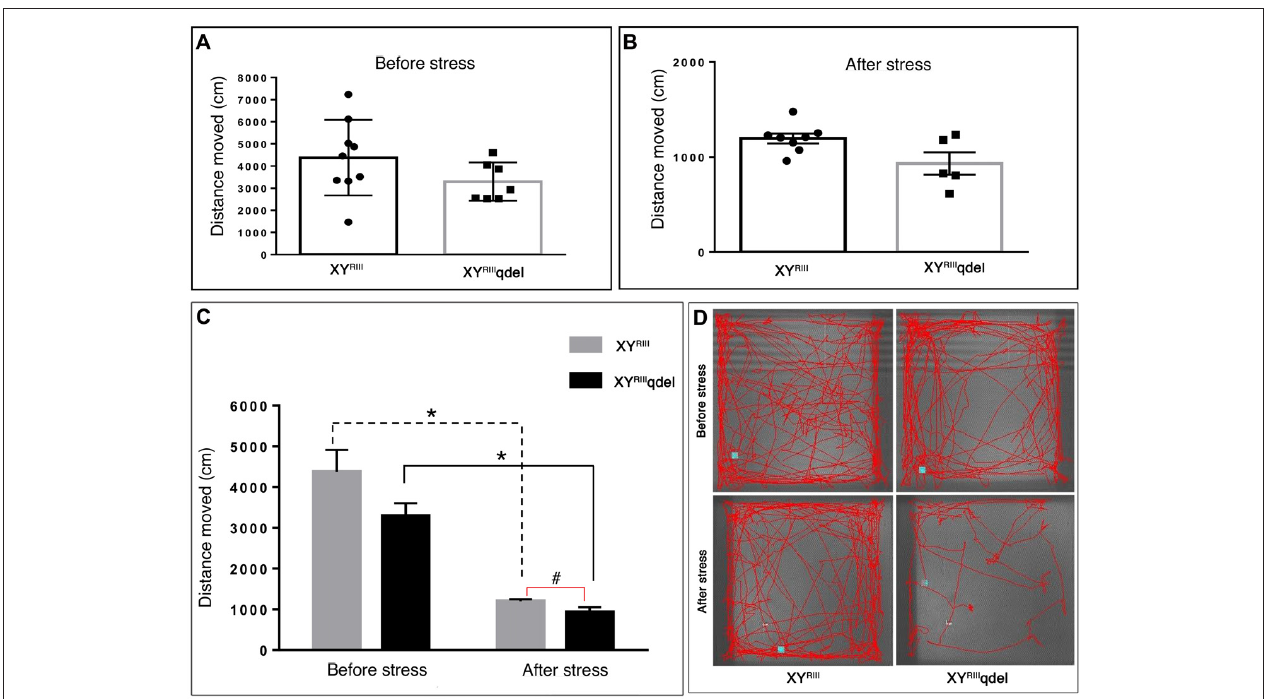
FIGURE 6 | The status of normal locomotion in XY RIII qdel and XY RIII mice before and after stress: distance moved. Before and after stress the mice did not show any difference in total distance moved during the test period as such in between genotypes (A,B) whereas, after the mice have undergone stress paradigm, XY RIII qdel showed a strong tendency of difference from the wild type in distance traveled ( P < 0.09) (C) . Similar to velocity data ( Figure 5 ) on comparison of movements before and after stress episodes both the groups have shown significant reduction in the same parameter. Data are expressed as the mean ± SEM. Solid line represents the difference between XY RIII qdel groups and dotted line represents the wild type before and after stress. ∗ P < 0.05, # P < 0.09, n = 8–10 per group in before stress, n = 6–8 per group in after stress experiments. Representative image of animal’s track from each group shown (D)